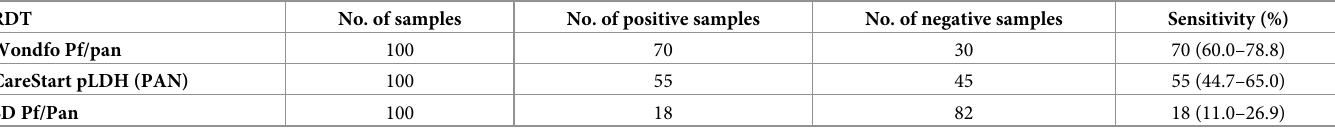
Table 2. Results for the detection of P . ovale infection by the three different RDTs. RDT